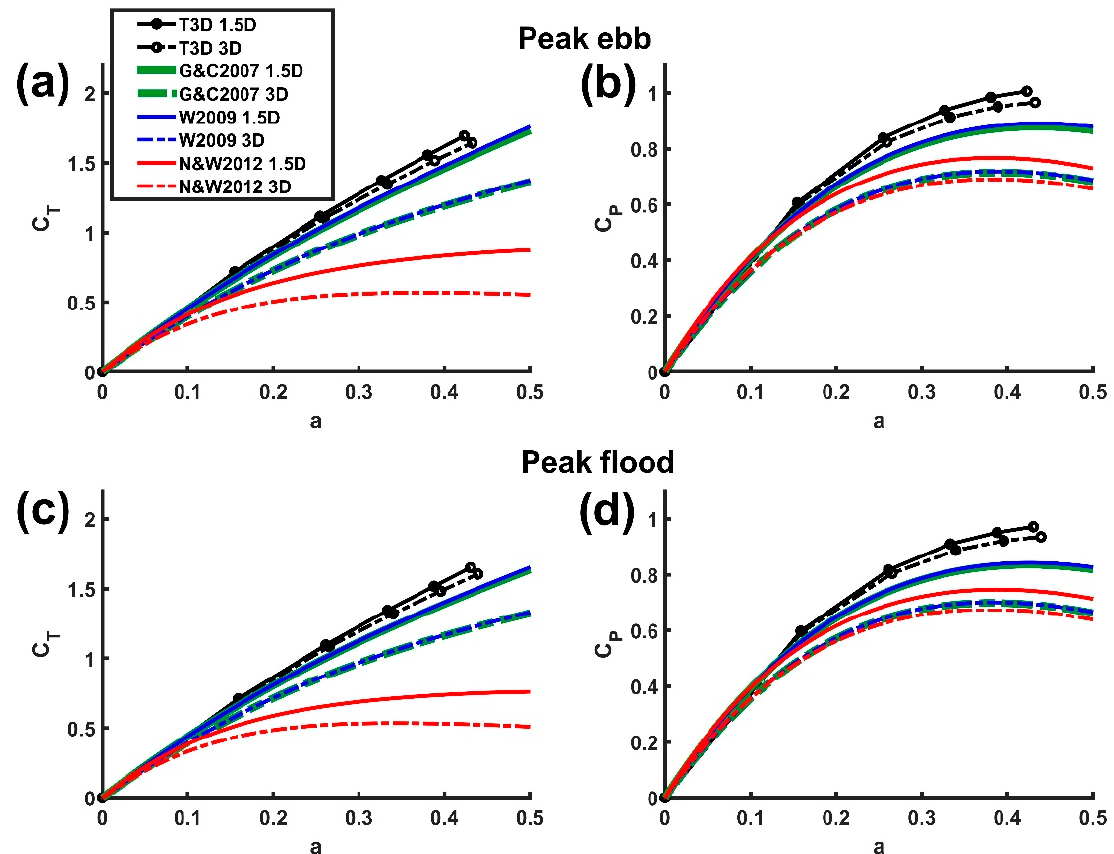
Figure 4 . Thrust ( a , c ) and power ( b , d ) coefficients as a function of the induction factor. Estimations are shown at peak ( top ) ebb and ( bottom ) flood of the mean spring tide represented in Figure 2.